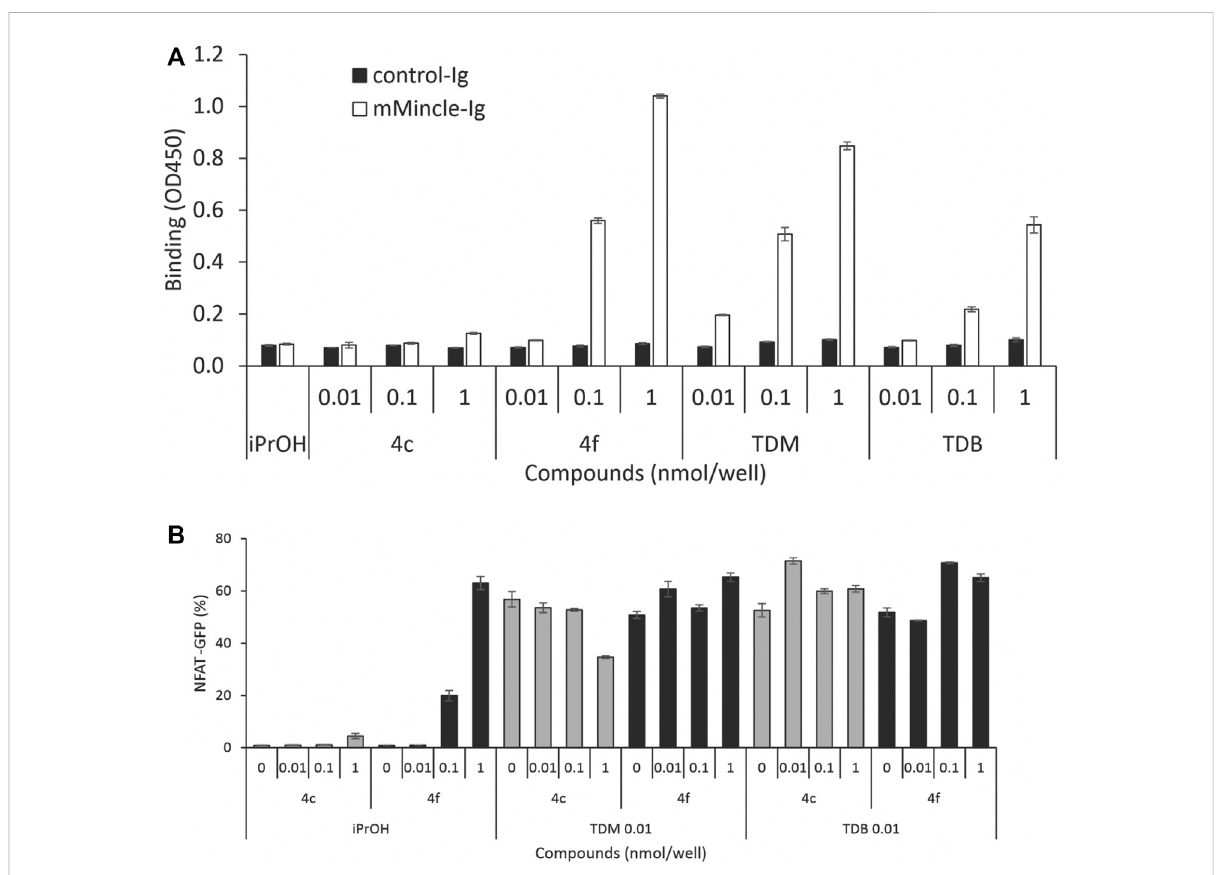
FIGURE 5 Water-soluble analogue 4f is a better ligand for mMincle compared to TDB and TDM but does not competitively inhibit the binding of TDB or TDM tomMincle. (A) Ligand coated plates (0.01, 0.1or1 nmol/well)wereincubated withmMincle-Ig orIgalone (3 μ g/ml) for 14 h, andligand bound protein determined using ELISA. Data obtained in a representative experiment performed in triplicate. (B) 2B4-NFAT-GFP reporter cells expressing mMincle were stimulated with 4c or 4f coated on plates (0, 0.01, 0.1 or 1 nmol/well) with TDM or TDB (0.01 nmol/well). GFP expression by